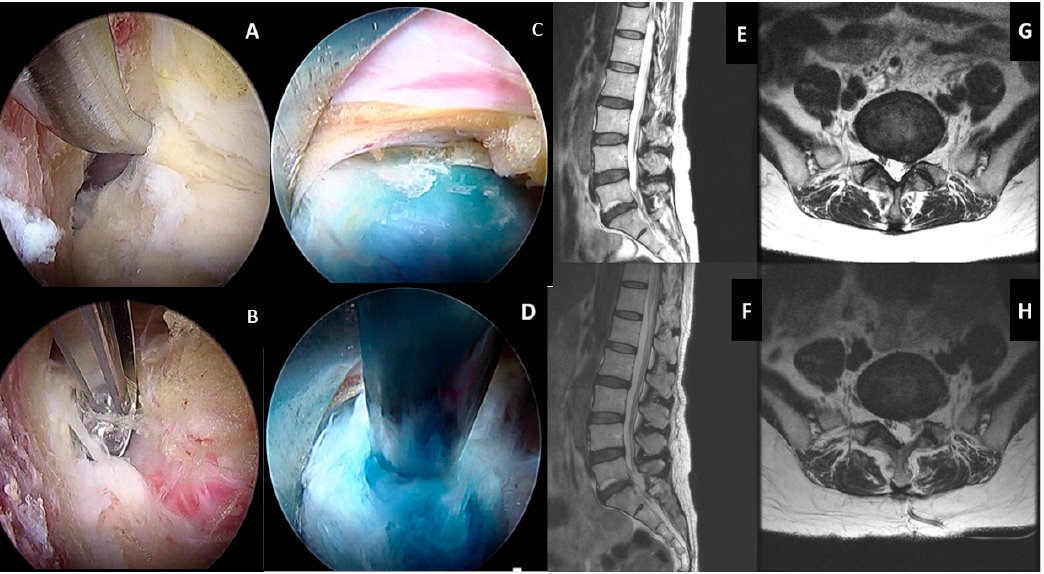
Figure 6. Posterior lumbar endoscopic unilateral laminotomy with bilateral decompression and discectomy over left lumbar five and sacral one. A shows the ligamentum flavum was lifted off from the caudal attachment in left L5/S1. B shows detachment of the remnant ligamentum flavum from the superior articular process of left side of S1. C shows the bulging disc, which is stained with indigo carmine. D shows discectomy performed using endoscopic forceps. E shows a prolapsed disc with neural element compression in the sagittal view MRI, which is decompressed in the same cut sagittal MRI in F . G shows a prolapsed disc with paracentral traversing nerve root compression with background thickening of the ligamentum flavum and spinal stenosis in the axial view MRI, which is decompressed with the ligamentum flavum removed and discectomy performed in H of the same cut axial MRI.